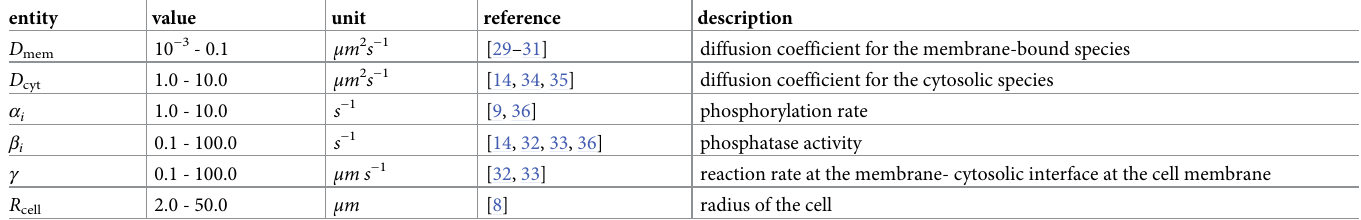
Table 1. An overview on values and parameters. For all parameters given in the table, the units apply to the numerical values in figures and text of the paper. entity value unit reference description diffusion coefficient for the membrane-bound species diffusion coefficient for the cytosolic